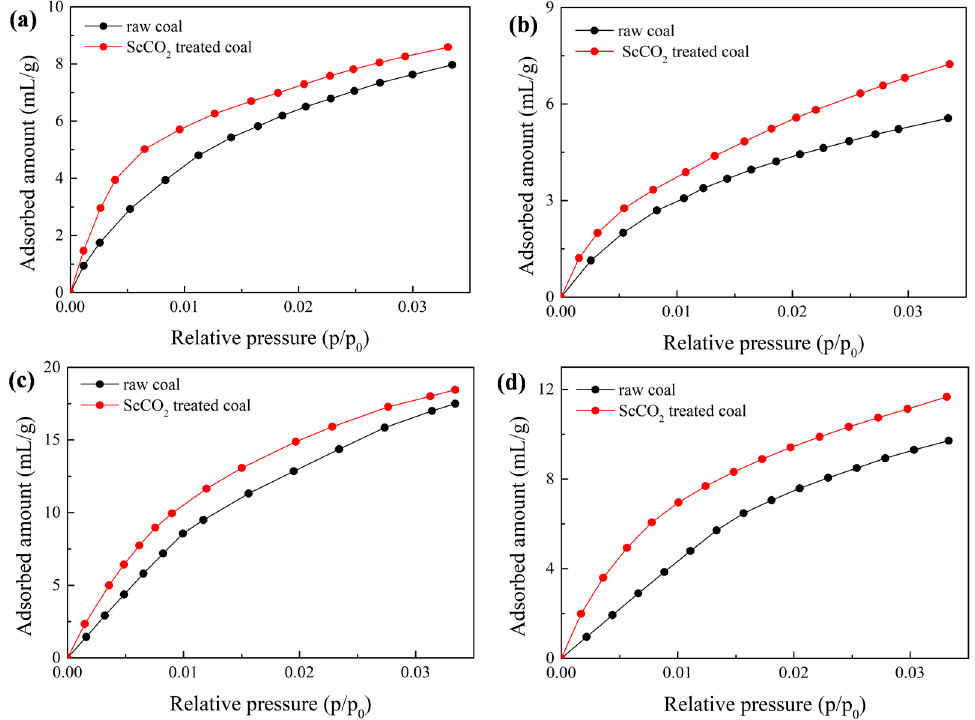
Figure 5. Low-pressure CO 2 adsorption isotherms on the raw and ScCO 2 -treated coal samples at 0 °C: ( a ) DL coal; ( b ) ZL coal; ( c ) GY coal; ( d ) DT coal.